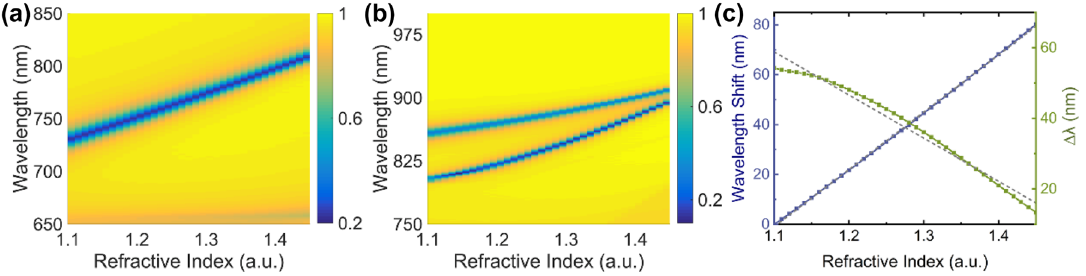
Figure 4: Sensing ability of two metasurfaces. (a) And (b) dependence of the transmission spectra on the environmental refractive index of the metasurfaces containing (a) two nanopillars of 100 nm height and (b) eight nanopillars of 200 nm height each period, respectively. (c) Variations of wavelength shift (blue curve) and Δ 𝜆 (green curve) with the refractive index for the corresponding two